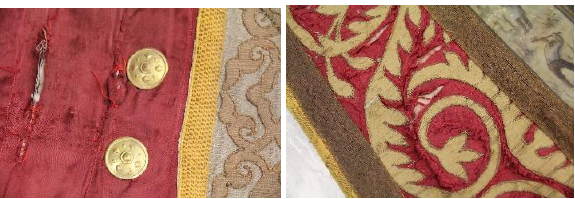
Figure 9 – Examples of tears on fabric elements on banners S. Vincent (left) and S. Adrião (right)